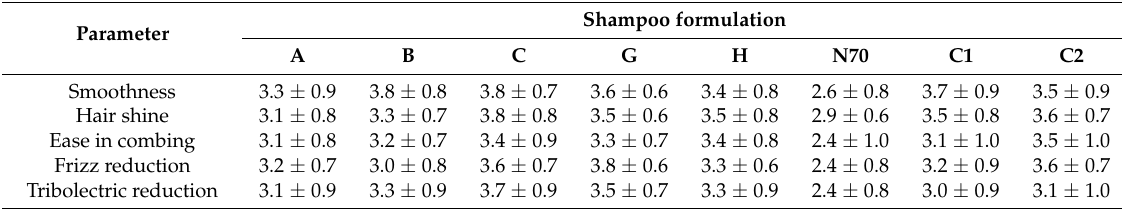
Table 6. Satisfaction scores of shampoo formulations in the terms of smoothness, hair shine, ease in combing, frizz reduction, and triboelectric